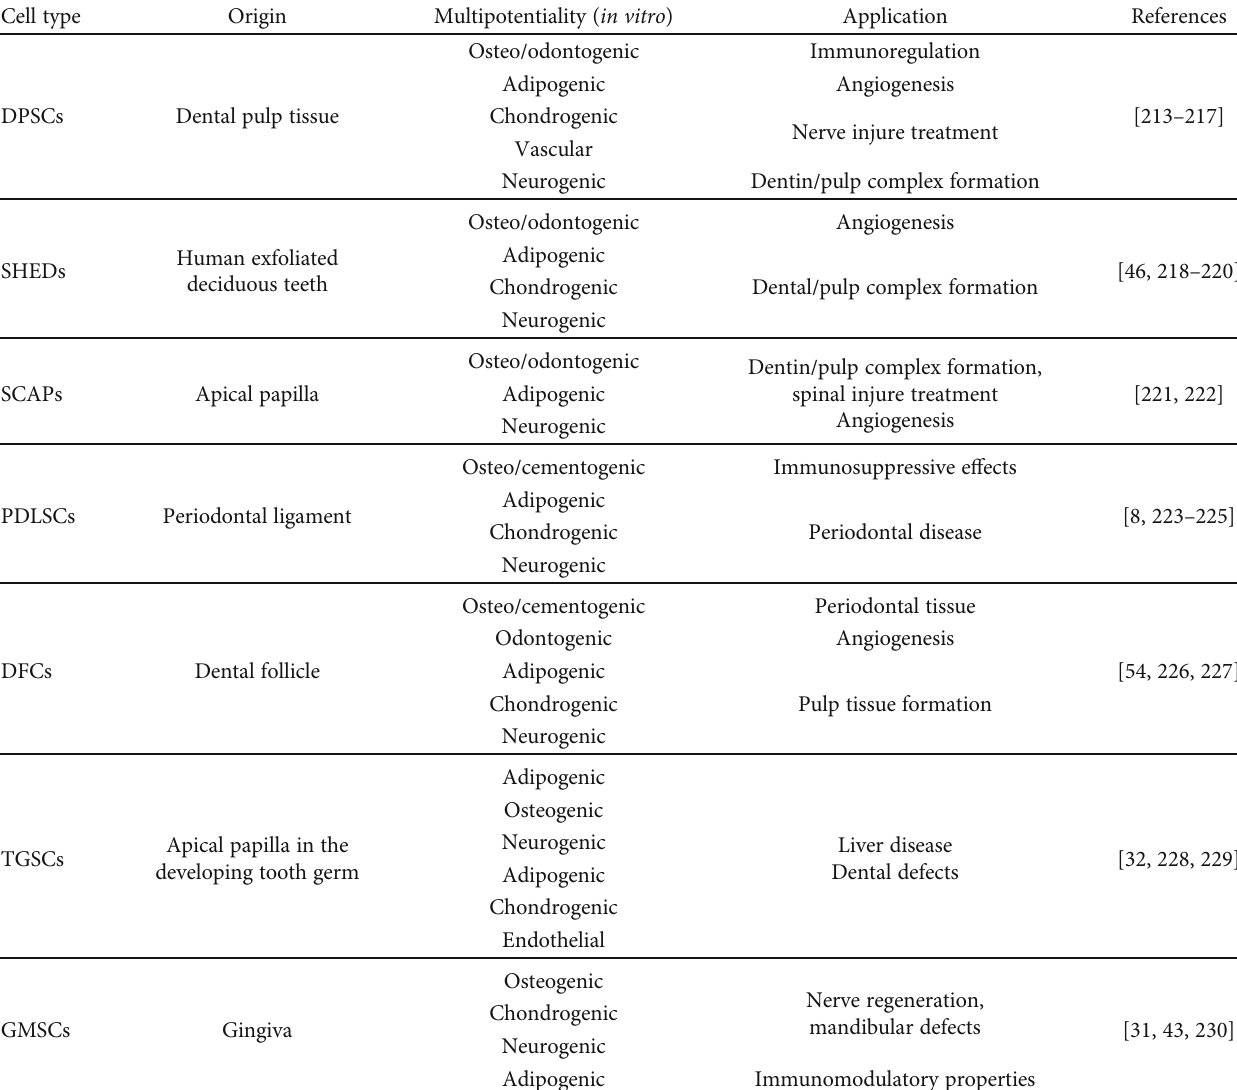
Table 1: Characteristics of dental-derived